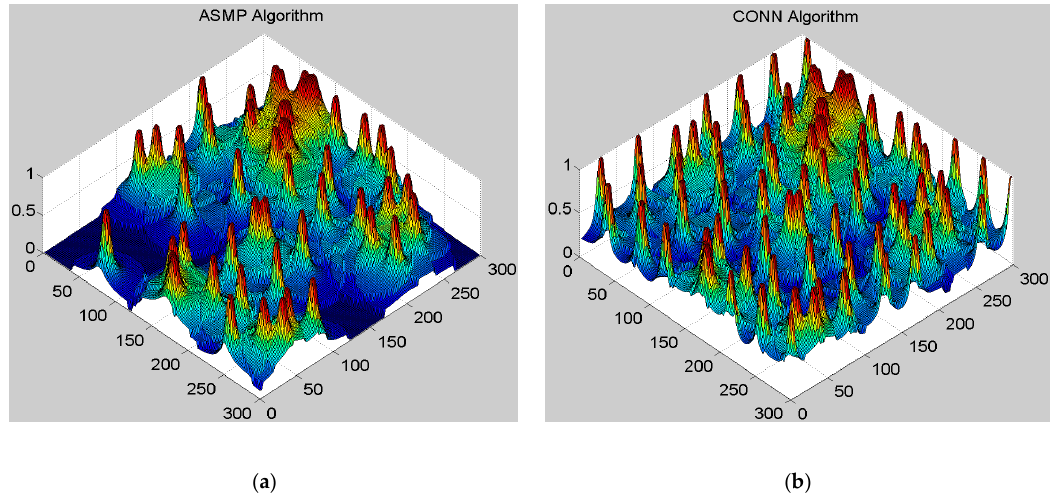
Figure 4. The CONN algorithm is compared with the ASMP algorithm in terms of the deployment intensity. ( a ) The deployment intensity of the ASMP algorithm; ( b ) The deployment intensity of the CONN algorithm.